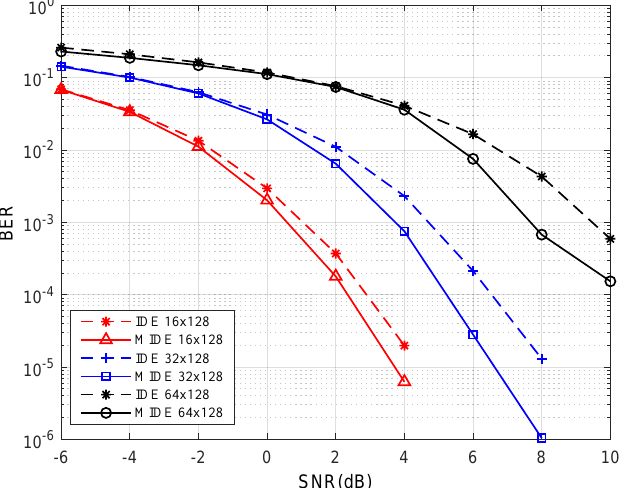
Figure 3. BER performance of the conventional damping factor and the proposed damping